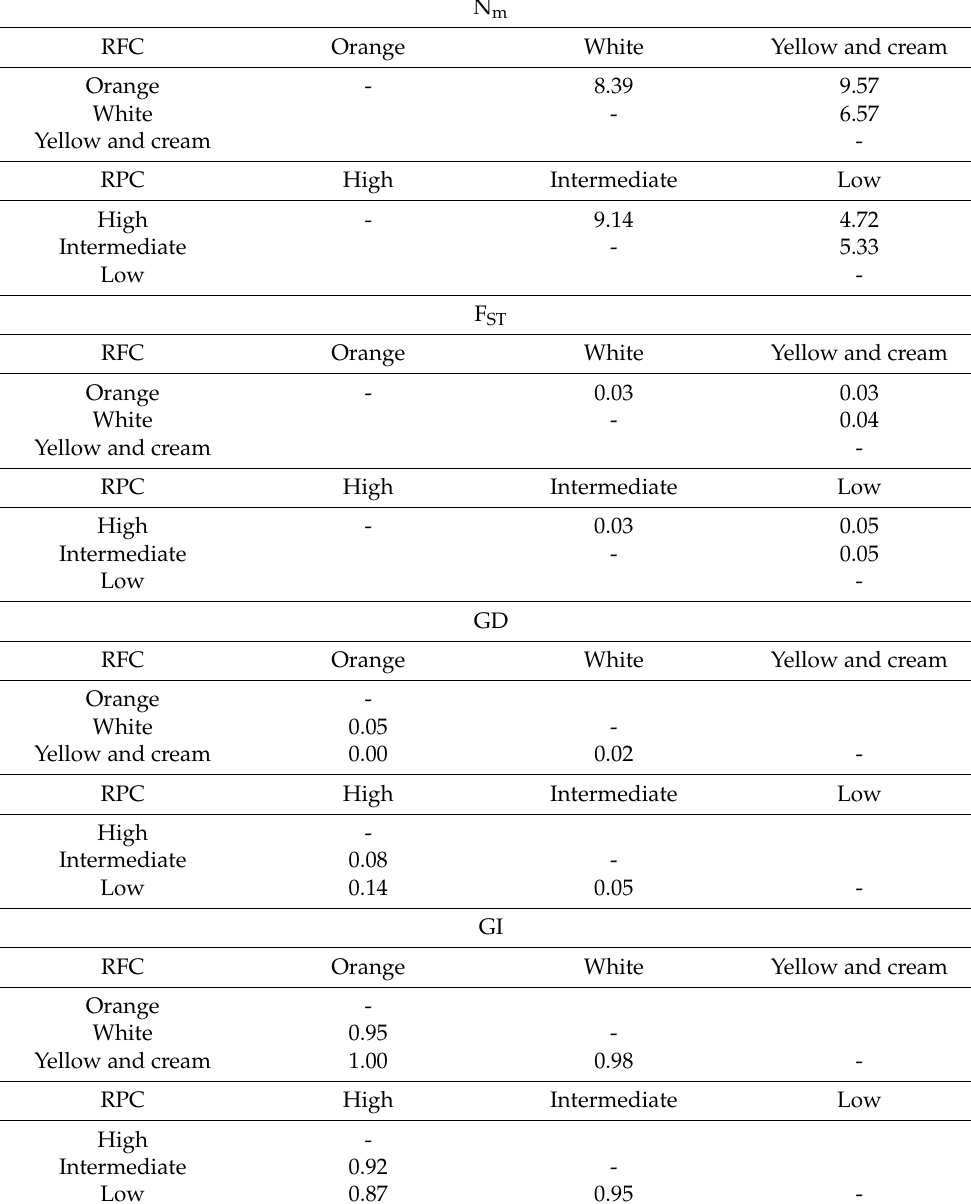
Table 5. Pair-wise estimates of gene flow (N m ), genetic differentiation (F ST ); genetic distance (GD), and genetic identity (GI) according to sub-groups based on root flesh colour (RFC) and levels of root protein content (RPC).